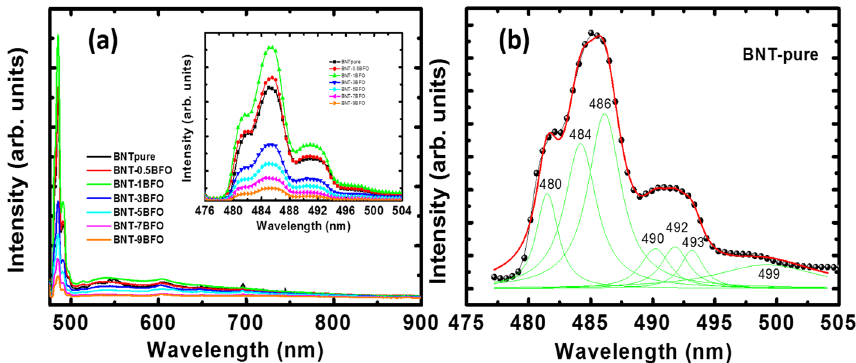
Figure 6. (a) PL spectral of pure Bi 0.5 Na 0.5 TiO 3 materials and BaFeO 3− δ -modified Na 0.5 Bi 0.5 TiO 3 samples as a function of BaFeO 3− δ concentration, and (b) deconvolution of PL spectral of pure Bi 0.5 Na 0.5 TiO 3 materials. The inset of (a) shown the magnification of PL spectral of pure and BaFeO 3− δ -modified Na 0.5 Bi 0.5 TiO 3 samples as a function of BaFeO 3− δ